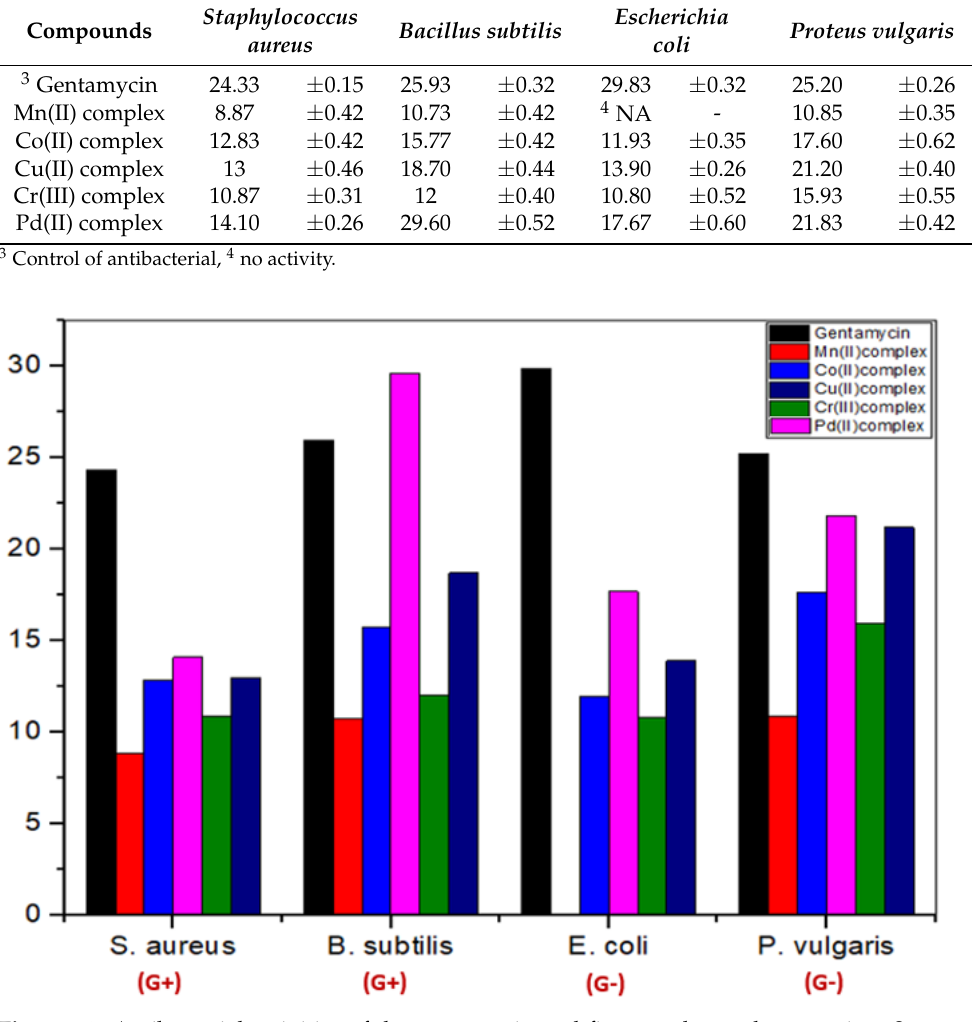
Figure 15. Microbiological screening of coordination compounds of Mn(II), Co(II), Cu(II), Cr(III), and Pd(II) toward Bacillus Subtilis .